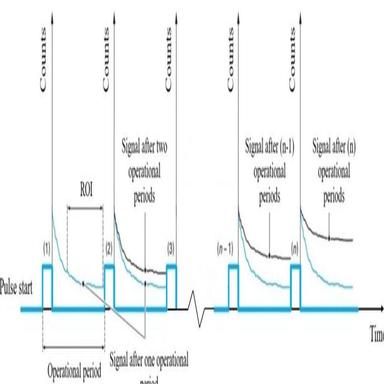
Schematic chronogram of the interpulse counting mode of delayed neutrons from photofission.